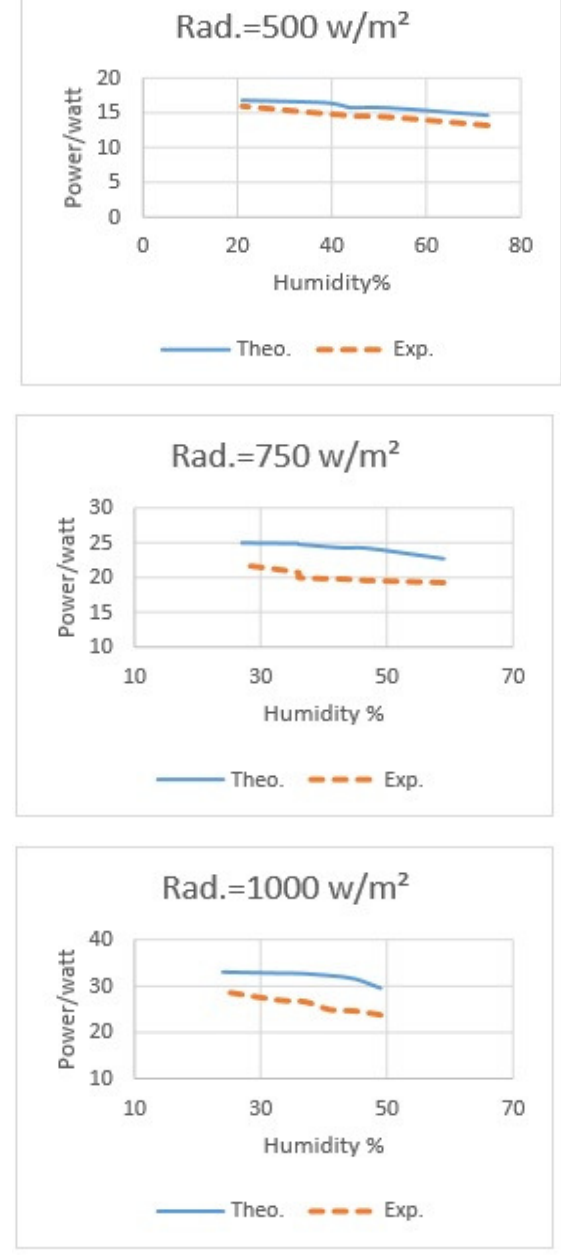
Fig. 9. Effect of humidity on power of monocrystalline PV solar cell at different radiation